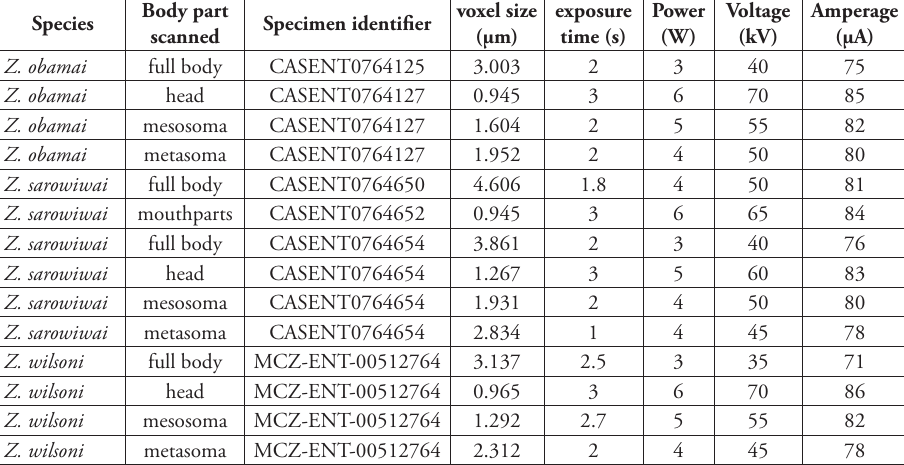
Table 1. Data summary for micro-CT scanning giving an overview of the specimens and body parts scanned for the three species and presenting specimen data, scan settings, and voxel sizes for the resulting scans (all specimens are workers and all files are in DICOM